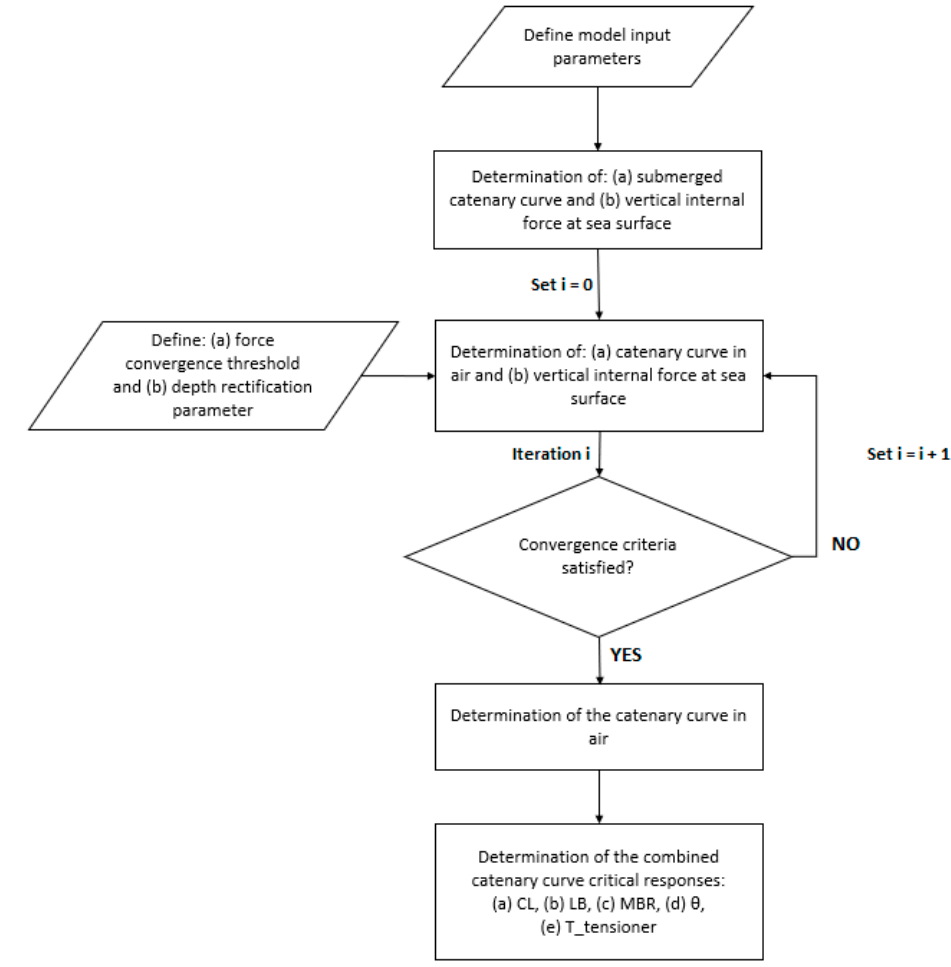
Figure 3. Procedural flowchart for the computation of the combined catenary curve.